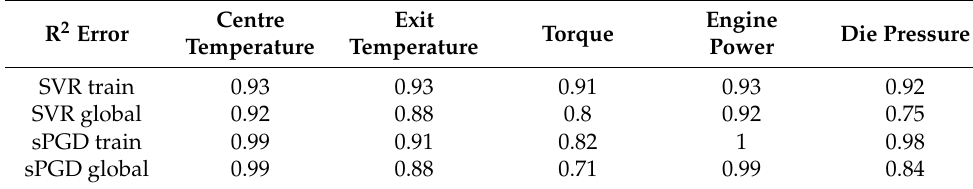
Table 4. R 2 scores errors for SVR and sPGD methods. R 2